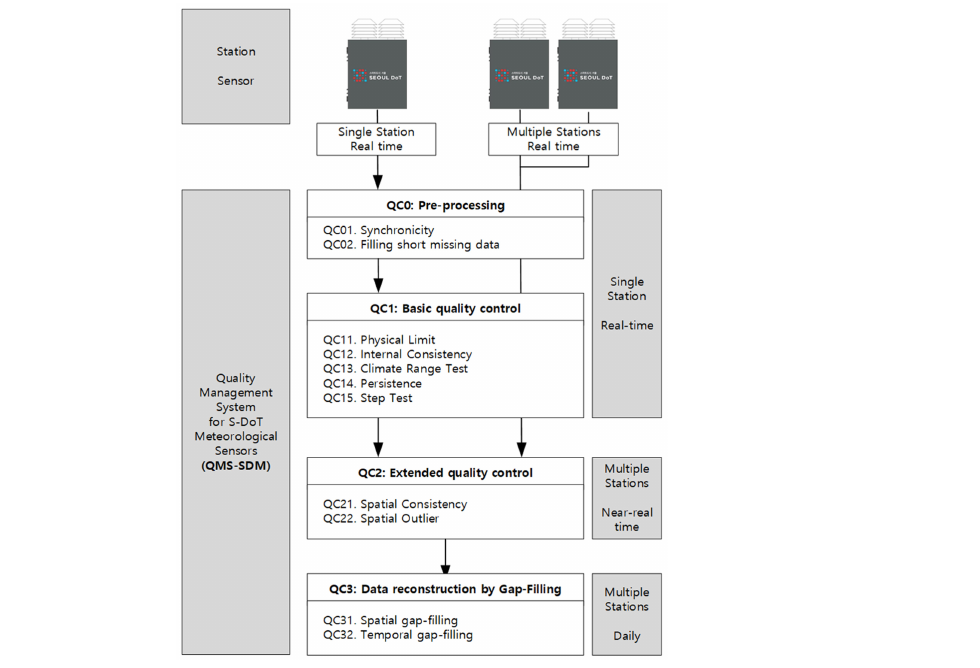
Figure 7. Flow chart of the quality management system for the S-DoT meteorological sensors (QMS-SDM). Table 3 shows the lower and upper threshold values for physical limit checks applied to the ASOS/AWS operated by the KMA and AWS operated by local governments. The KMA and local governments used the same threshold values for relative humidity, wind speed, and direction. The AWS (local governments) applied − 45 °C to the lower threshold values for air temperature, whereas the ASOS/AWS (KMA) applied − 35 °C. The S-DoT sensors showed different lower and upper limits. The lower and upper limits were set to be − 40 °C and 80 °C for air temperature, 0% and 100% for relative humidity, 0 m s − 1 and 60 m s − 1 for wind speed, 0 ° and 360 ° for wind direction, respectively (Table 3).